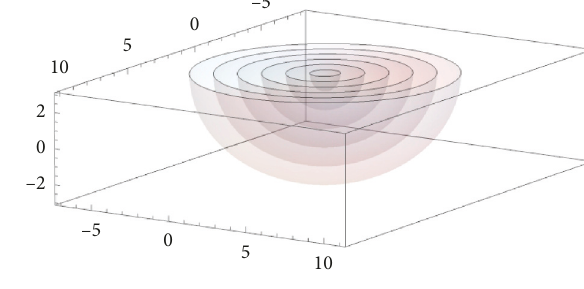
Figure 12: A − B 3 D half − cut .